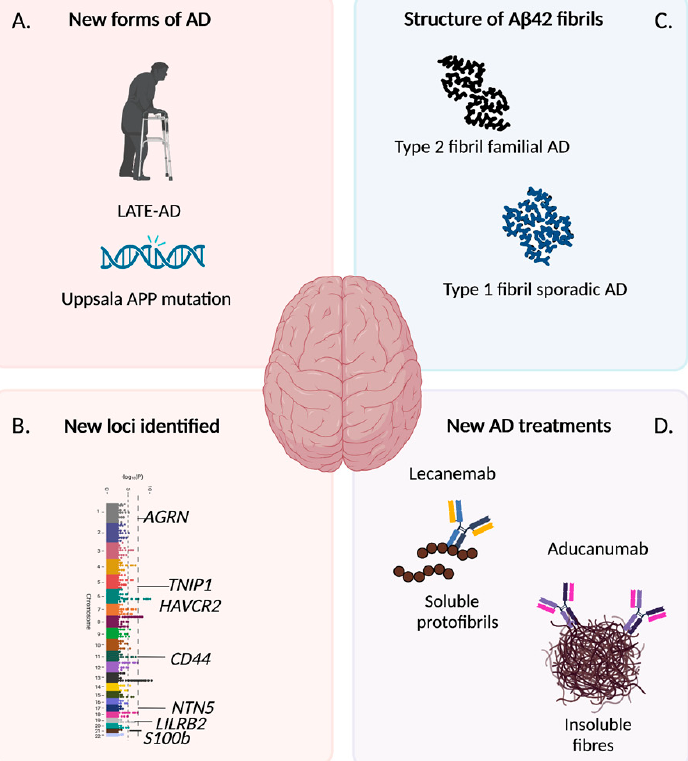
Figure 1. Highlighted major breakthroughs in the Alzheimer’s disease (AD) field over the last decade. New forms of AD have been identified including a sporadic form called LATE [2] and a familial form referred to as the Uppsala APP mutation [3] ( A ). New gene loci associated with development of AD have been identified, with a few of the recent loci from [4] and [5] shown here ( B ). Researchers have identified the structural insights of amyloid beta (A β ) showing fibrils differ between familial and sporadic AD [6] ( C ). Progress has recently been made in finding treatments for AD including Lecanemab and Aducanumab, which have recently been approved and marketed in the US. Both target the removal of A β but have different preferences in their ability to remove either soluble protofibrils or insoluble fibers ( D ). Created with